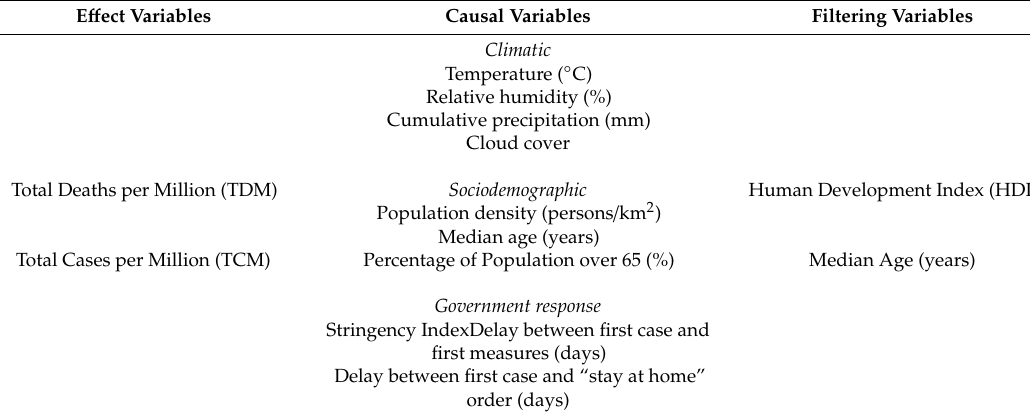
Table 1. Variables considered in the statistical